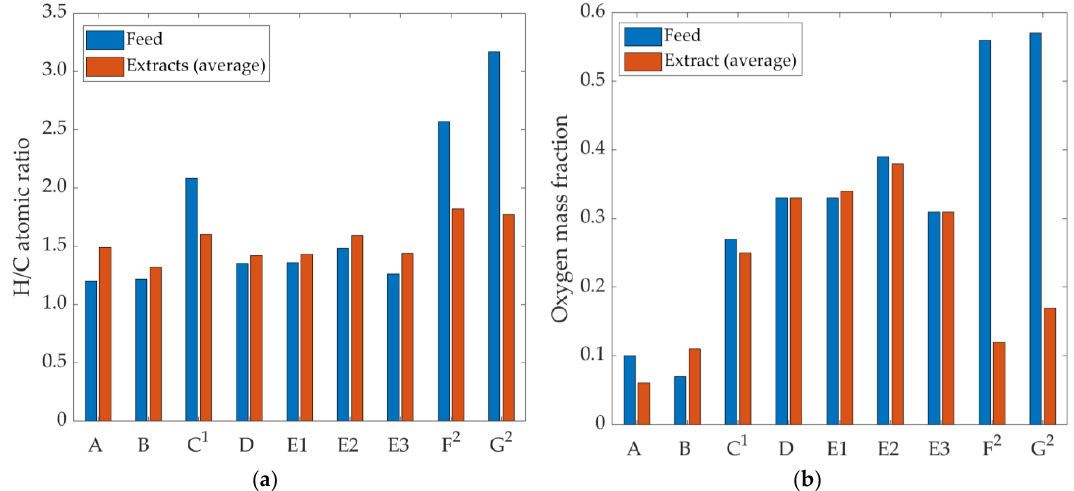
Figure 6. (a) H/C atomic ratio and (b) oxygen mass fraction of bio-oils (feed) and their sCO 2 extracts on a water- Figure 6. ( a ) H / C atomic ratio and ( b ) oxygen mass fraction of bio-oils (feed) and their sCO 2 extracts